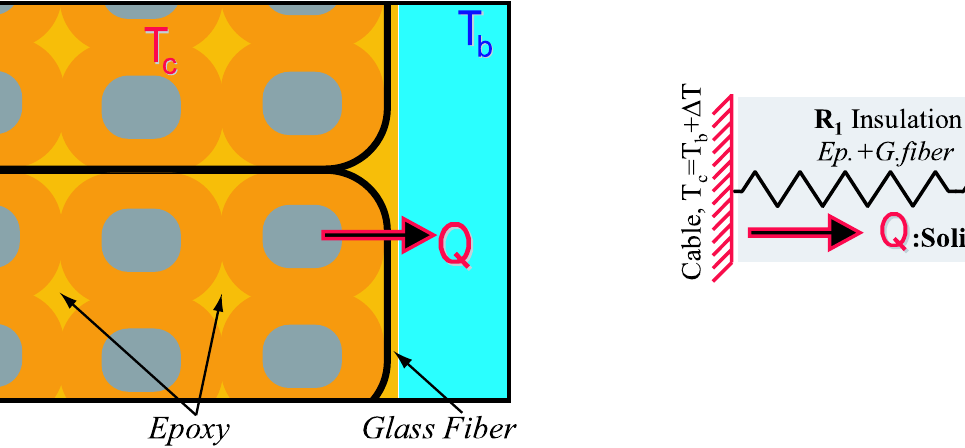
FIG. 3. (Color) Schematization of heat transfer path through nonporous insulation.